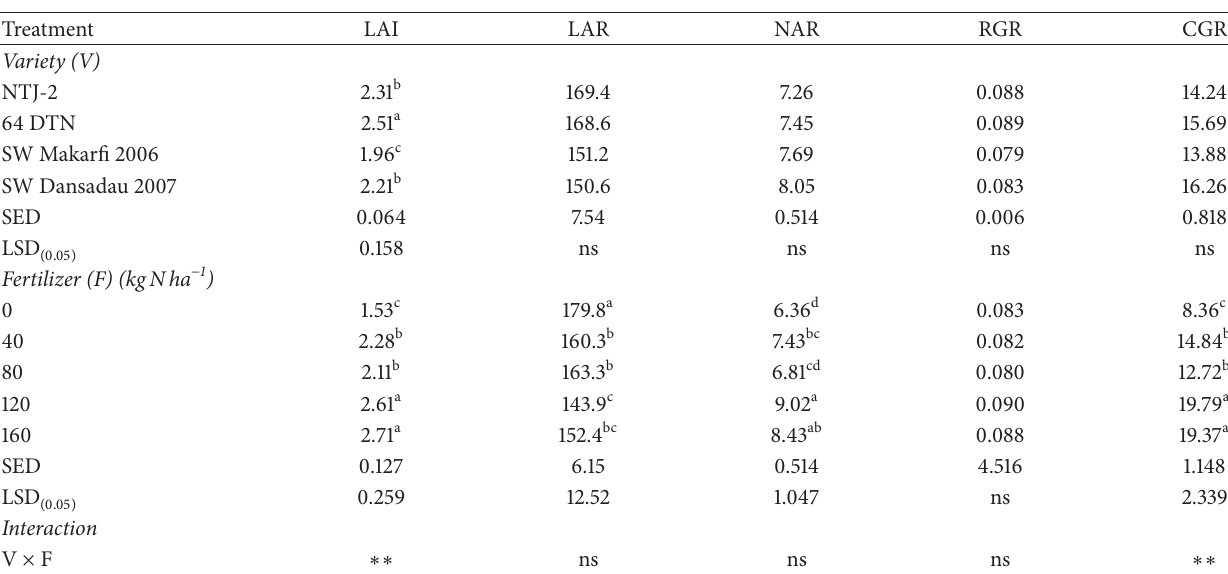
Table 3: (a) Main effects of variety and N fertilizer on the leaf area index (LAI), leaf area ratio (LAR, cm 2 g −1 ), net assimilation rate